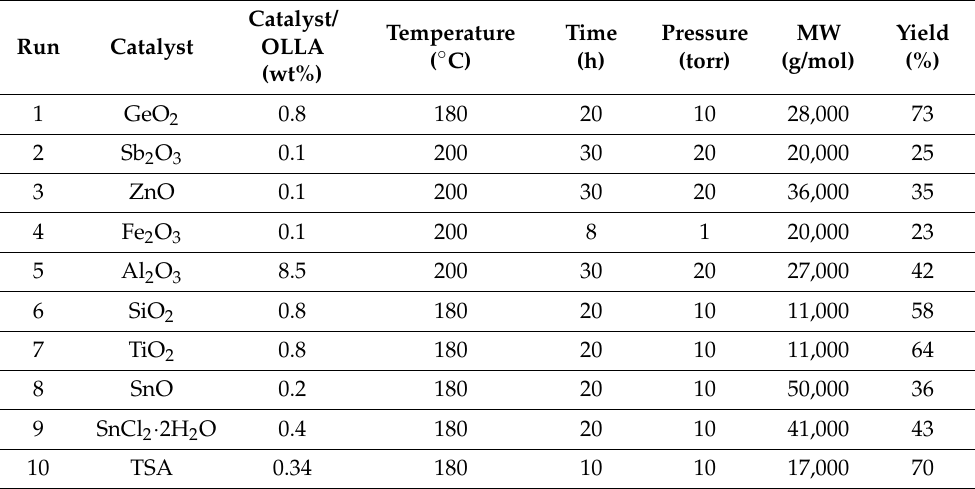
Table 1. Typical results of the catalyst screening test for the melt polycondensation of OLLA Reprinted with permission from ref. [40]. Copyright 2000 John Wiley & Sons,